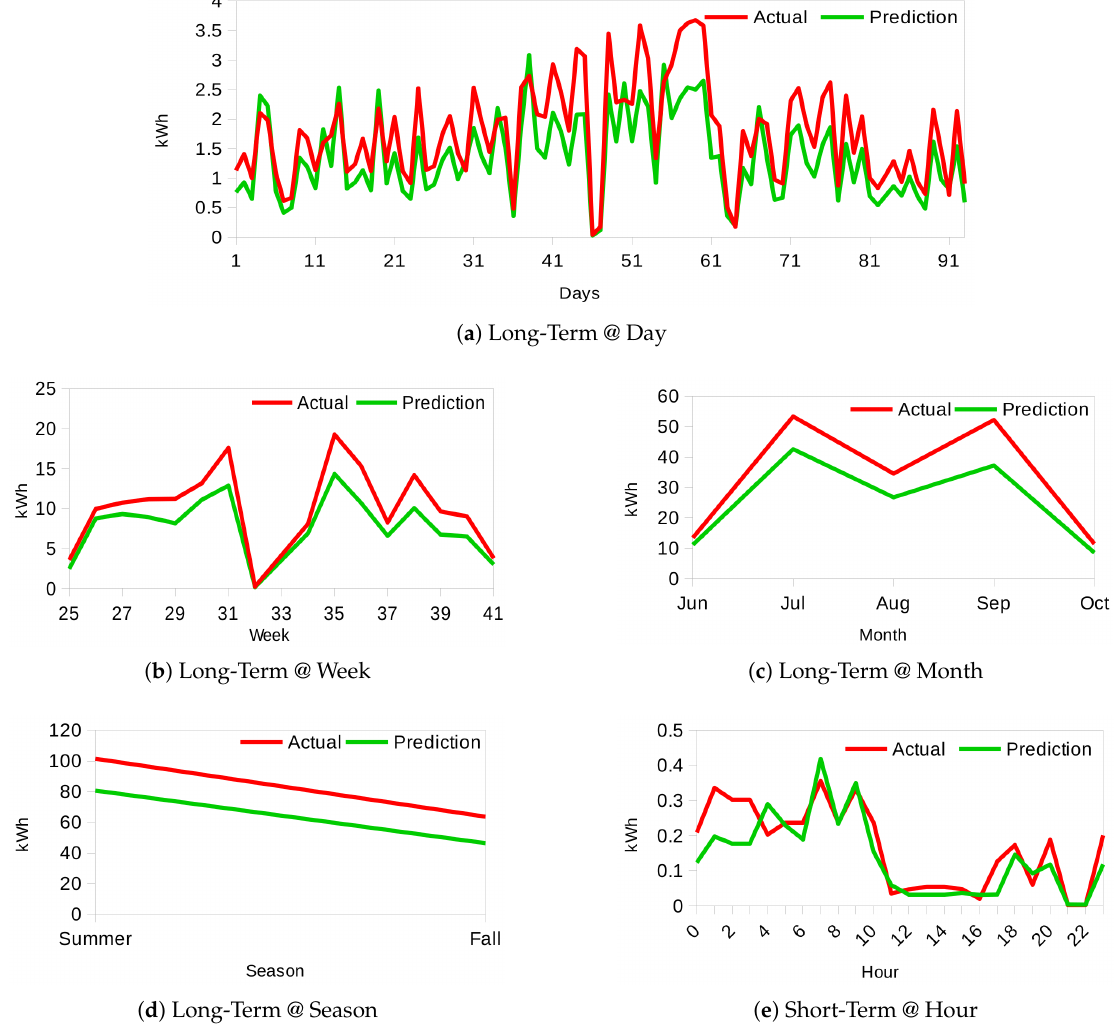
Figure 6. House 3: energy consumption prediction vs. actual energy